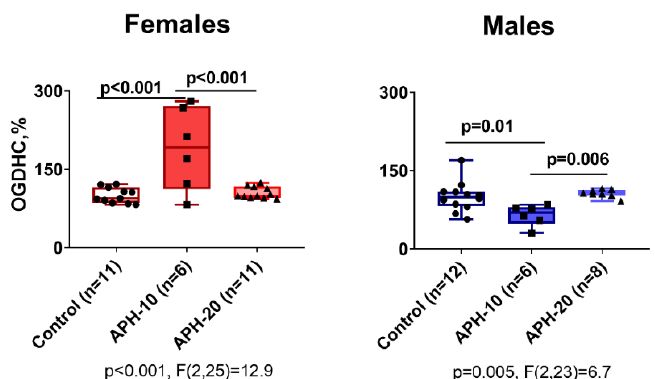
Figure 4. Influence of acute prenatal hypoxia on the activity of OGDHC in the brain cortex of the female and male offspring exposed to APH on the 10th or 20th day of gestation. Activities in the brain cortex of the adult female or male offspring are presented as the means ± SEM. The p -values on the graphs indicate significance of the differences between the groups, estimated by using one- way ANOVA with Tukey post hoc test. For the activities with significant ( p < 0.05) differences the p -values and F-statistics of one-way ANOVA are shown below the graphs. n —the number of rats in each group.